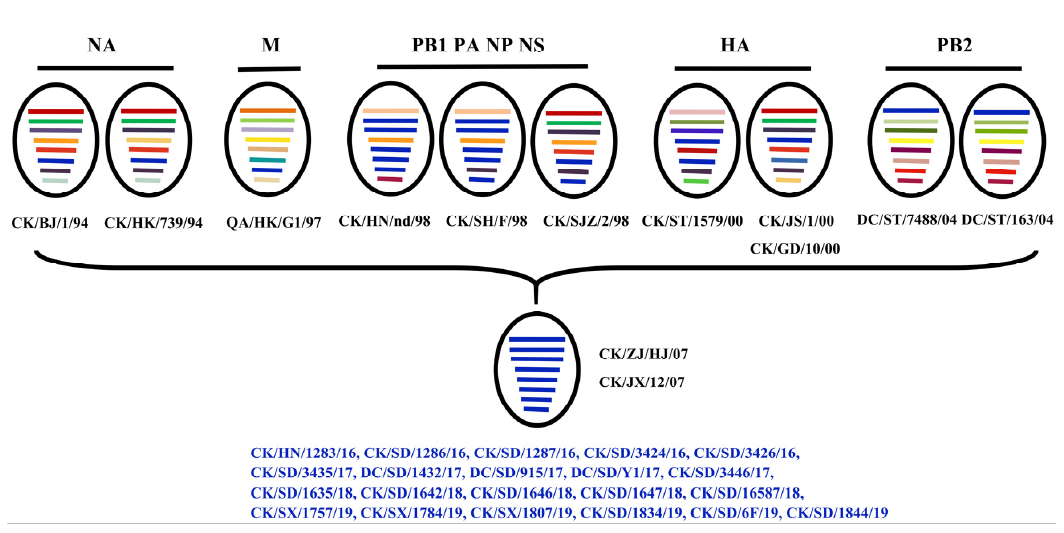
Figure 5. Genotypes of Chinese H9N2 viruses isolated from 2016 to 2019. Viral genotypes were analyzed for the H9N2 viruses based on gene phylogenic analysis and determined by the combination of clade assignments of each of the eight segments according to a previous study [20]. The eight gene segments are (horizontal bars from the top) PB1, PB2, PA, HA, NP, NA, M, and NS. Each color represents a viral segment